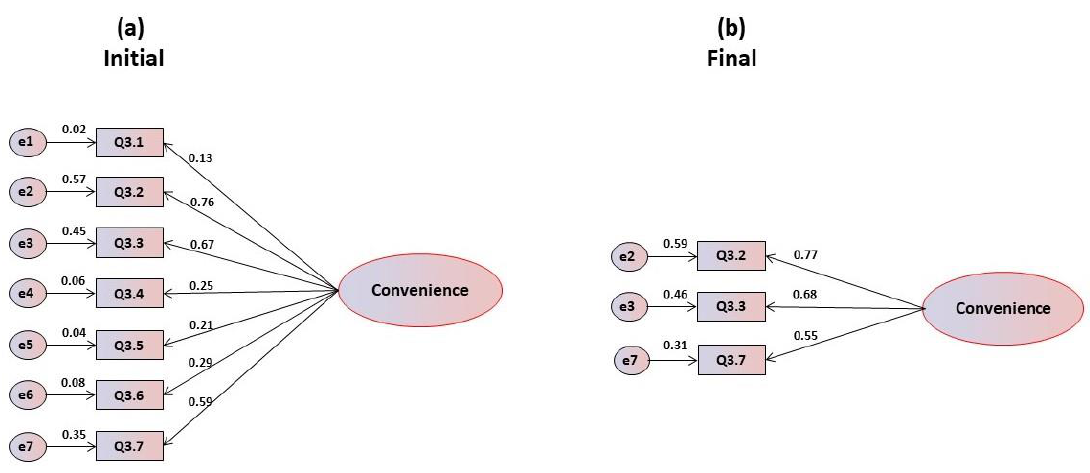
Figure 3. ( a ) Initial and ( b ) final models for the economic and availability motivations’ scale.